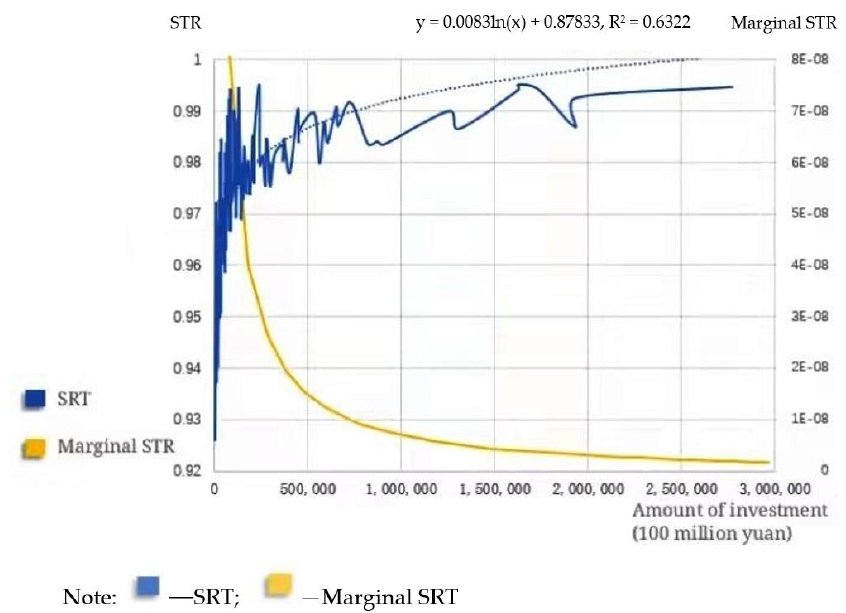
Figure 3. SRT and marginal SRT curves.